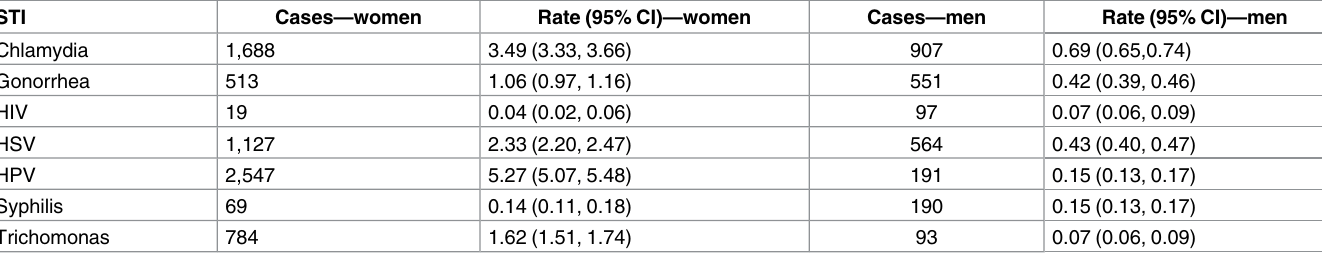
Table 4. Case-rates (per 1,000 person-years) for individual STIs among women and men.